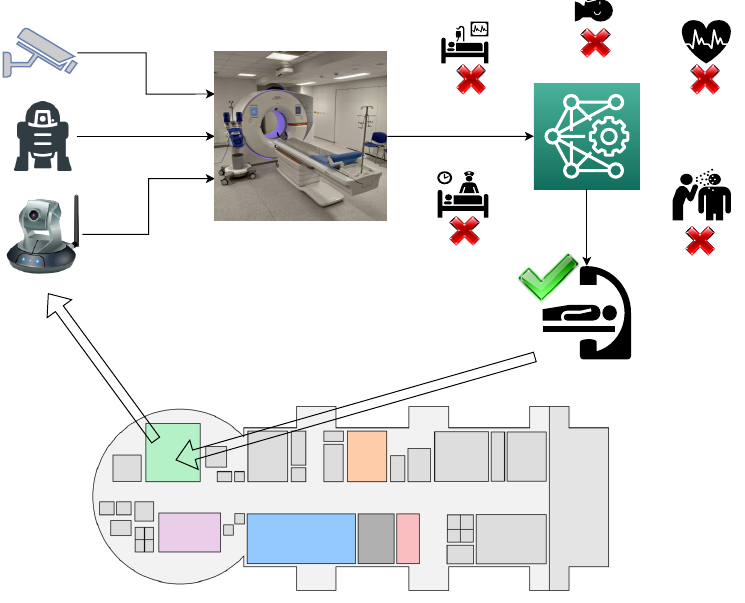
Figure 1. Schematic representation of the proposed system. Images of rooms that are taken by robots, surveillance cameras or other sources are interpreted by the designed classifier and labelled with a specific use. Hospital CAFM systems are then continuously updated with this